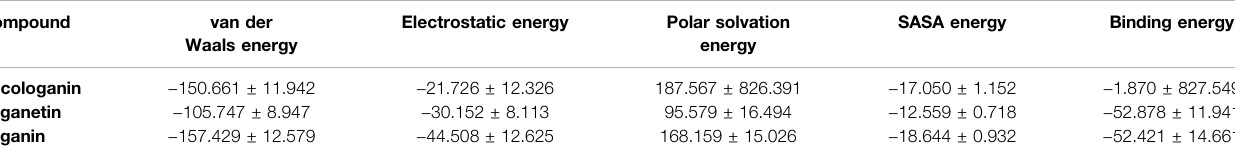
TABLE 5 | Table represents the Van der Waals, electrostatic, polar solvation, SASA, and binding energy in kJ.mol_1 for secologanin, loganetin, and loganin.